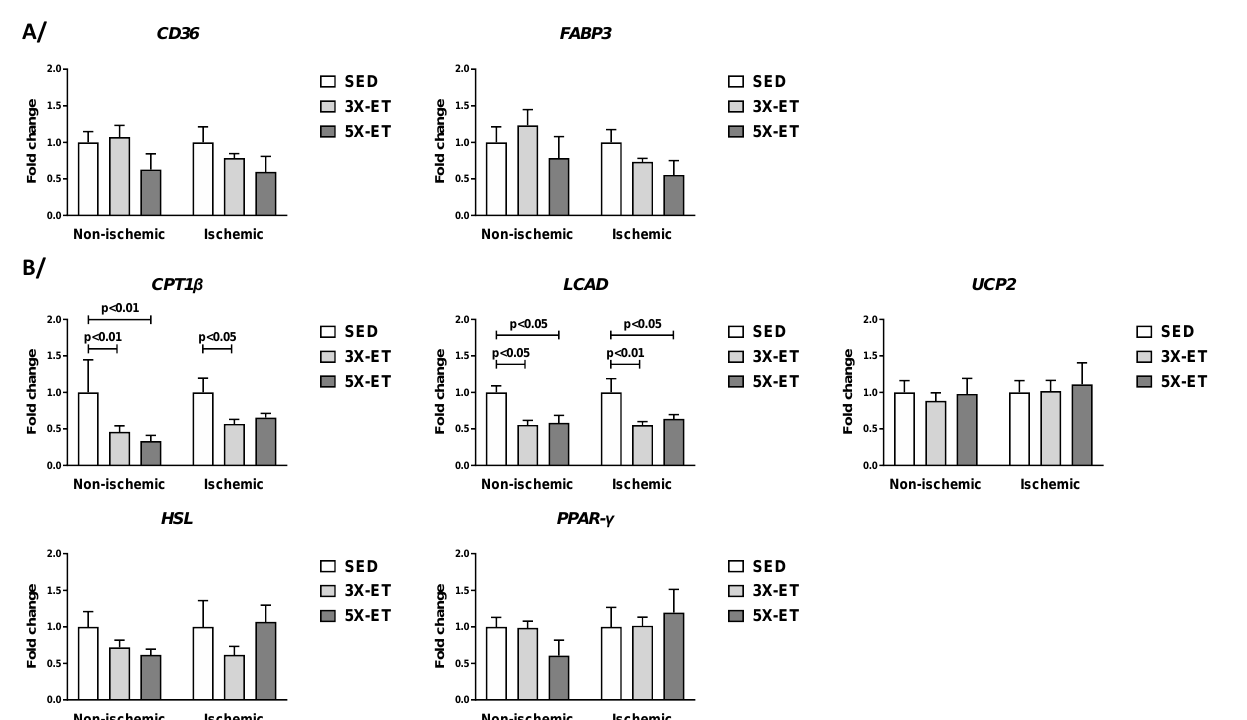
Figure 4. Expression of genes involved in fatty acid uptake ( CD36 ) and transport ( FABP3 ) ( A ), and fatty acid β-oxidation ( CPT1β , LCAD , UCP2 , HSL and PPAR-γ ) ( B ) in non-ischemic and ischemic muscles of sedentary (SED), three times (3X-ET), and five times (5X-ET) a week exercised ApoE −/− mice with PAD. Data were normalized to 36B4 gene and expressed as fold-change over respective SED group. Results presented as the mean ± SEM ( n = 6–8 mice per group). Data were analyzed using one-way ANOVA with Holm–Sidak’s post hoc tests.